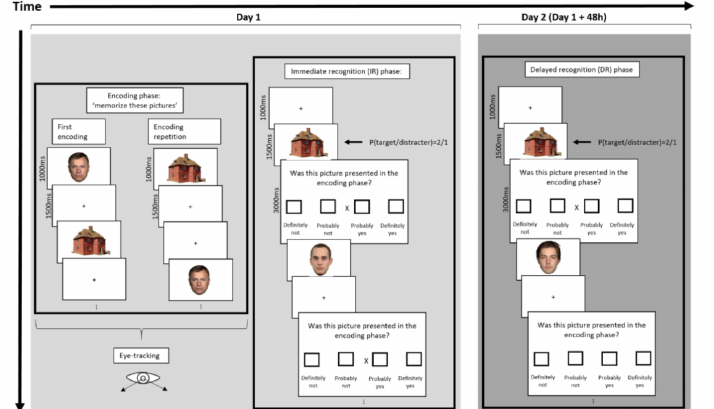
Figure 2. Schematic design presentation of the protocol. The experiment consisted of an encoding phase, an immediate recognition phase (IR), and a delayed recognition phase (DR). Eye move- ment data was collected during the encoding phase. The encoding phase ( left panel ) consisted of two sessions. In each session, 80 stimuli (40 houses and 40 faces) were pseudo-randomly presented. The second encoding session (encoding repetition) was identical to the first except for the order of stimulus presentation. Prior to the encoding phase, participants were instructed to memorize the stimuli of the encoding phase in order to recognize them in a subsequent recognition test. The IR phase ( middle panel ) directly followed the encoding phase. In the IR phase, the stimuli consisted of the 80 stimuli from the encoding phase intermixed with an additional 40 distractors: 20 houses and 20 faces. The trials were equally divided over 4 sessions during the IR phase. The response screen displayed the question “Was this picture presented in the encoding phase?” with four boxes below referring to four response alternatives: “definitely not”; “probably not”; “probably yes”; “definitely yes”. The DR ( right panel ) is conducted two days after the first session (48 h). The DR is identical to the IR, except for the stimulus presentation order and the distracter stimuli, i.e., 40 new distractors were presented in the DR.